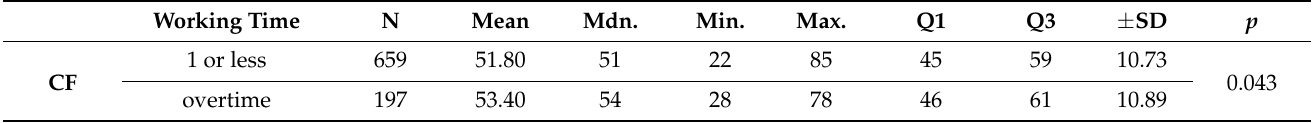
Table 3. Impact of working time on compassion